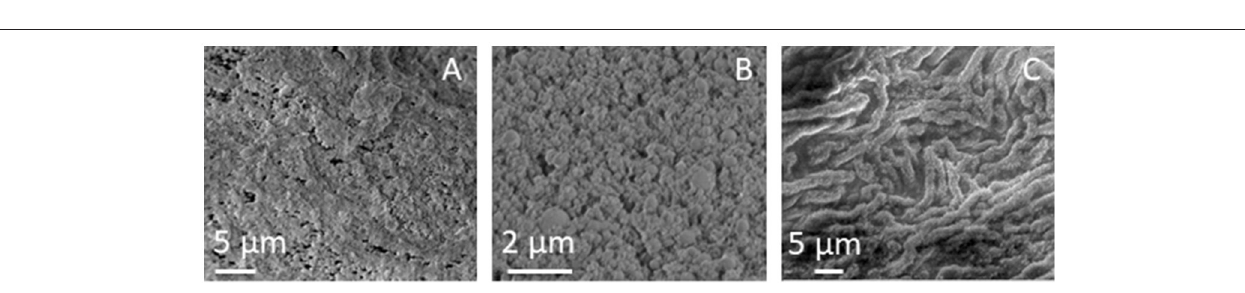
Frontiers in Chemistry |